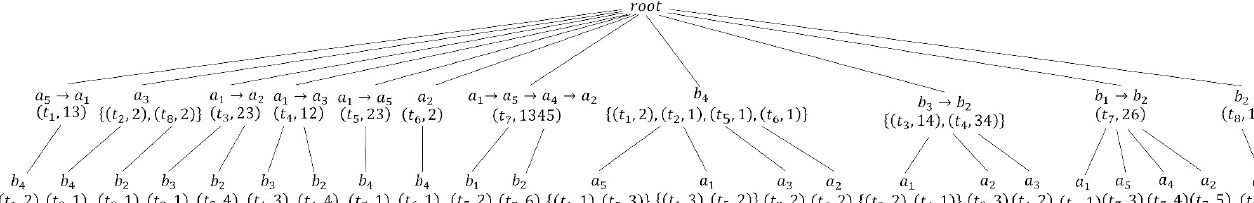
Figure 1. The TP-tree in Table 1. The 2nd-level nodes of the TP-tree correspond to projection trajectories, and the 3rd-level nodes correspond to locations that may be